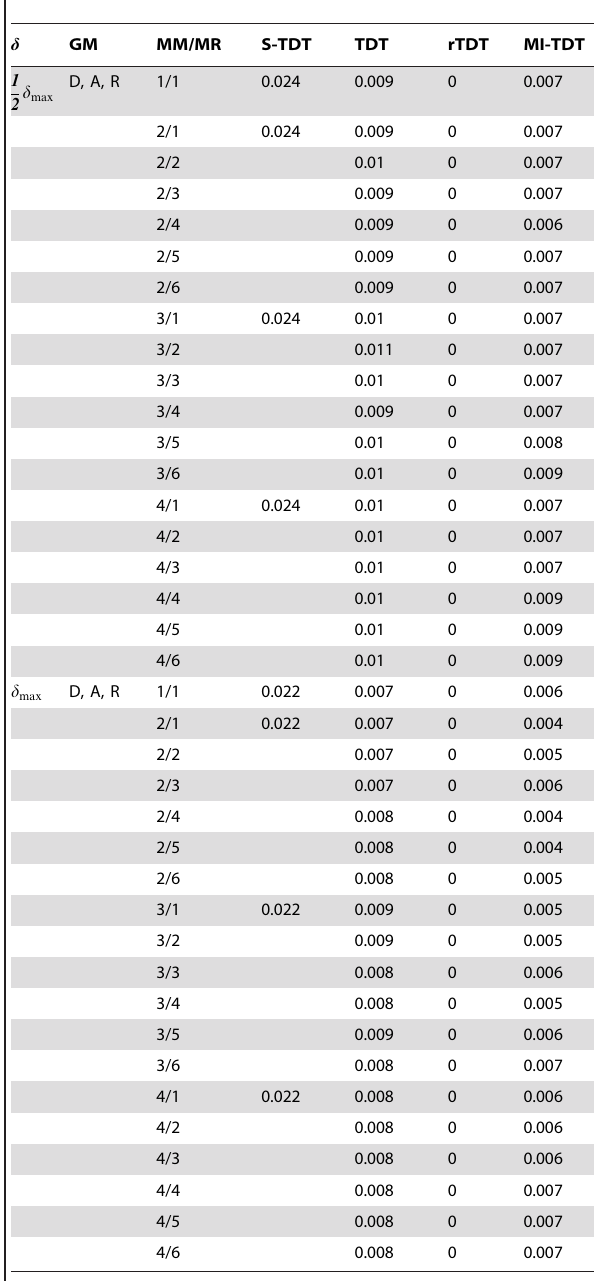
Table 7. Missing model (MM) and missing rates (MR). Missing Rates